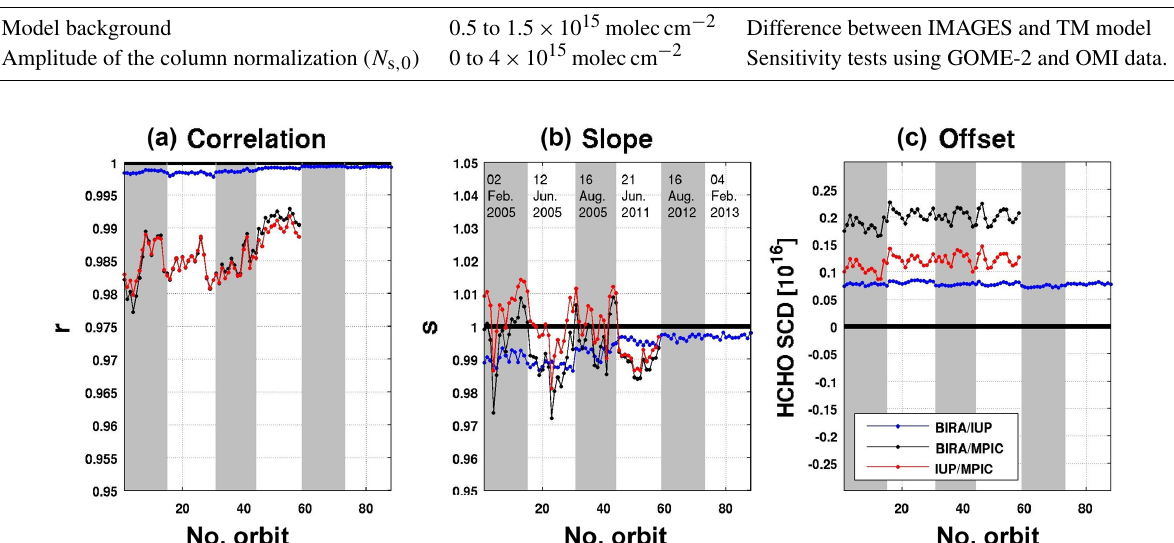
Figure 13. Correlation (a) , slope (b) , and offset (c) from a linear regression performed for the common fit settings (see Table 11) for each orbit of OMI test days. A correlation plot for an example orbit is provided in the left panel of Fig.